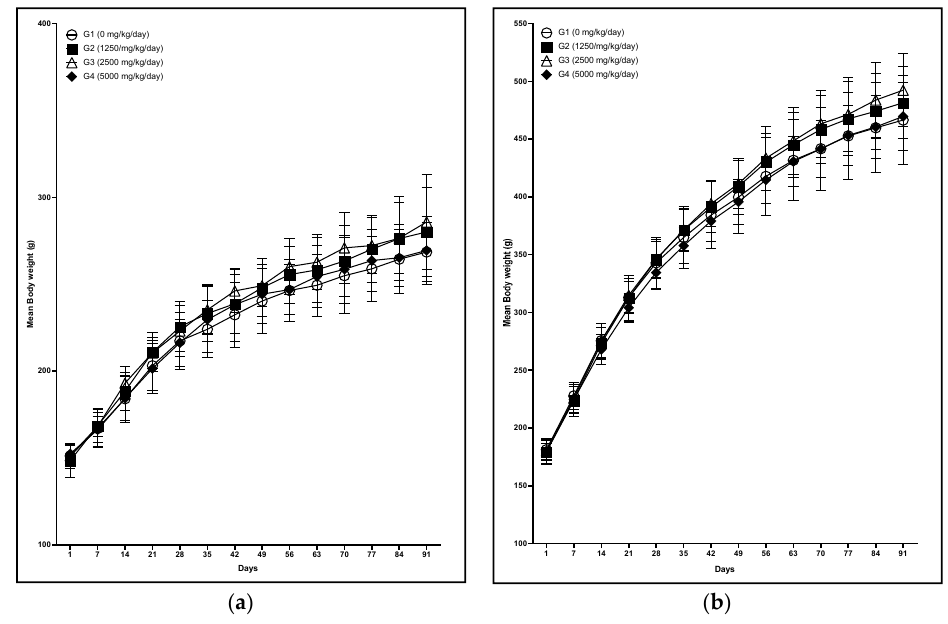
Figure 2. Mean body weight of male ( a ) and female ( b ) rats administered with frpfdZAL for 13 weeks. Each value represents the mean ± standard deviation ( n = 10). ( a ) male; ( b ) female.